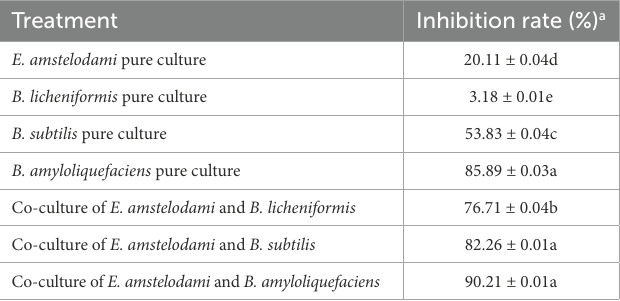
TABLE 1 Co-culture and pure culture of E. amstelodami and Bacillus species showed different inhibition effects on S. aureus .